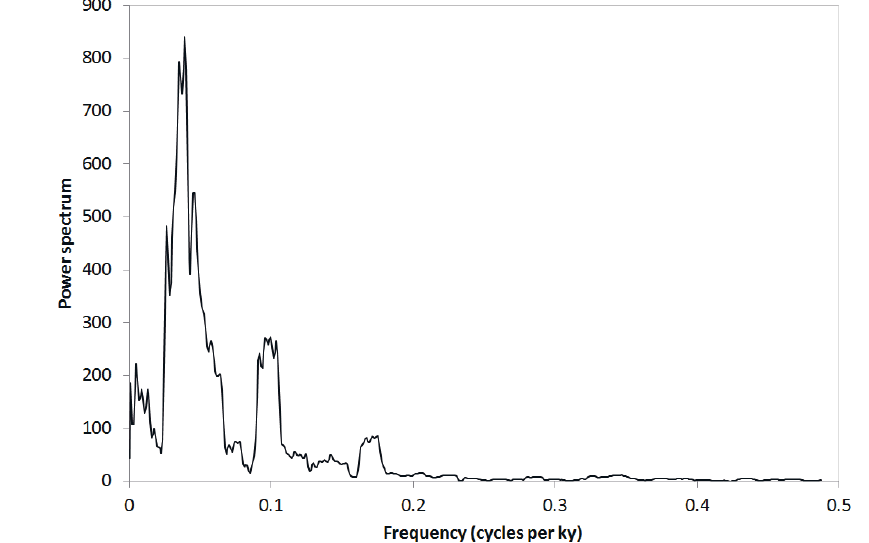
Figure 9. Power spectrum estimated by the Thomson multitaper method with 5 tapers. The Nyquist frequency is 0.5, which corresponds to a period of 8 Ky.